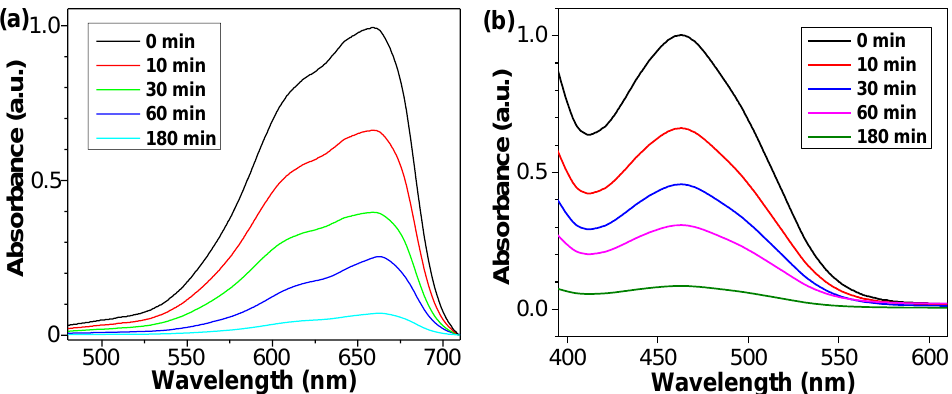
Figure 4. UV-vis absorption spectra of ( a ) MB and ( b ) MO after mixing mPVA/AC CG with 50 wt% of AC at pH 7 for different times. The initial dye concentration was 0.1 mM.